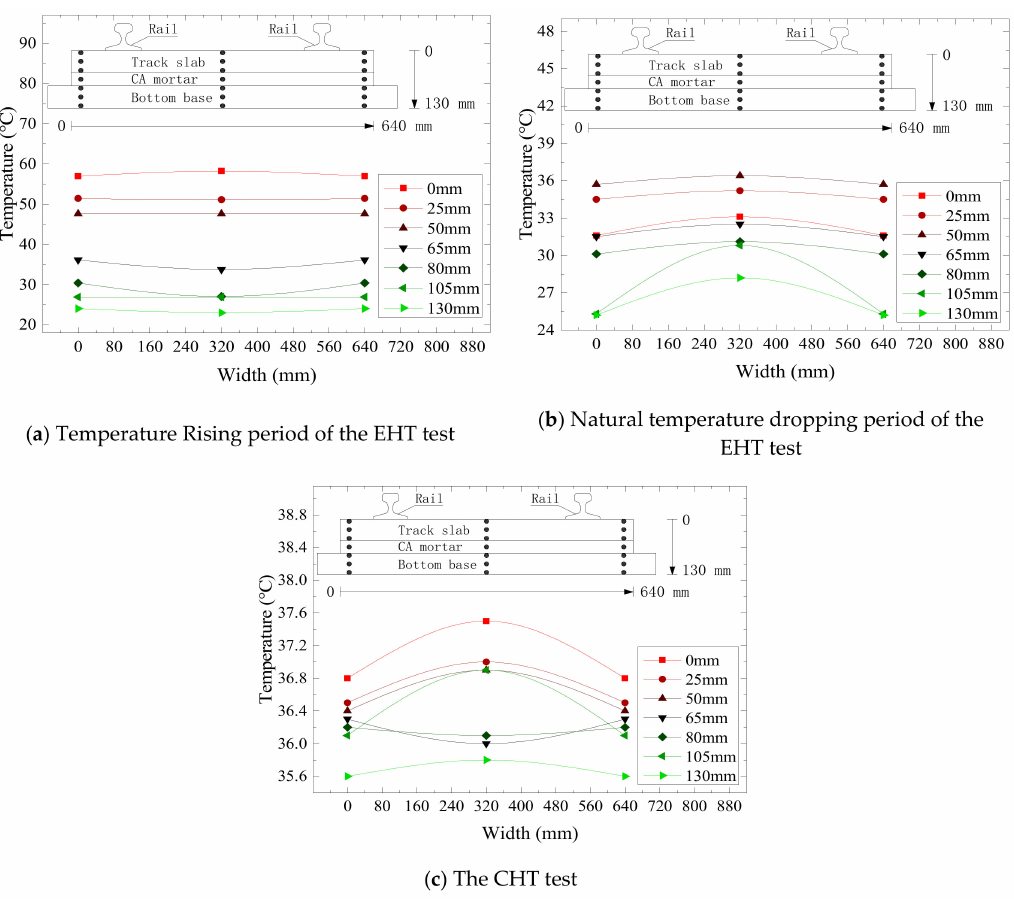
Figure 9. Transverse temperature